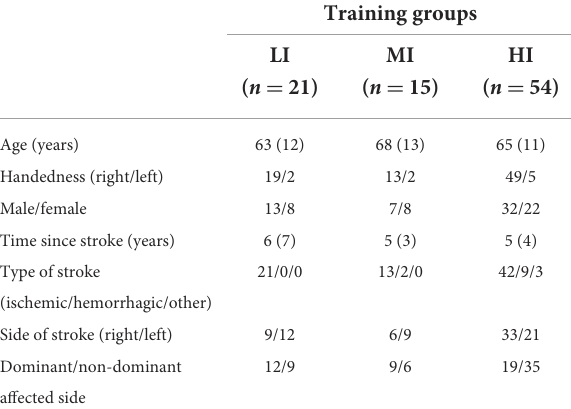
TABLE 1 Participants sociodemographic characteristics [mean (SD)] in each training